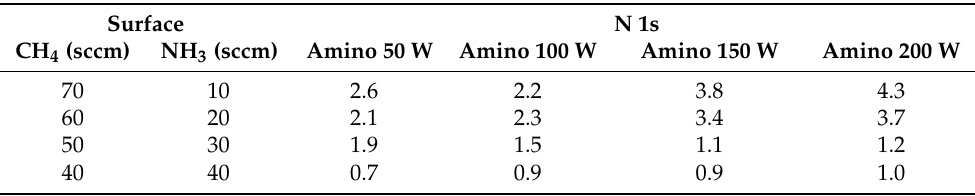
Table 3. Amino nitrogen (%) values quantified by XPS for surfaces plasma-coated using different relative amounts of CH 4 and NH 3 in the feed (reported in the first two columns). The power varied from 50 to 200